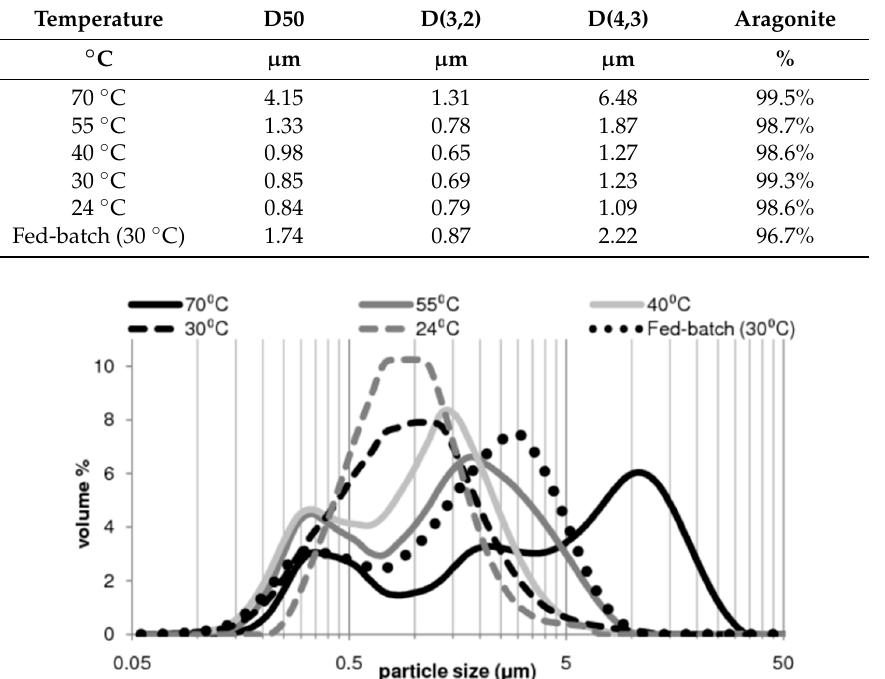
Figure 5. Particle size distributions of pure aragonite precipitates at varying temperatures [23]. Re-used with permission from Elsevier (4366260353846).